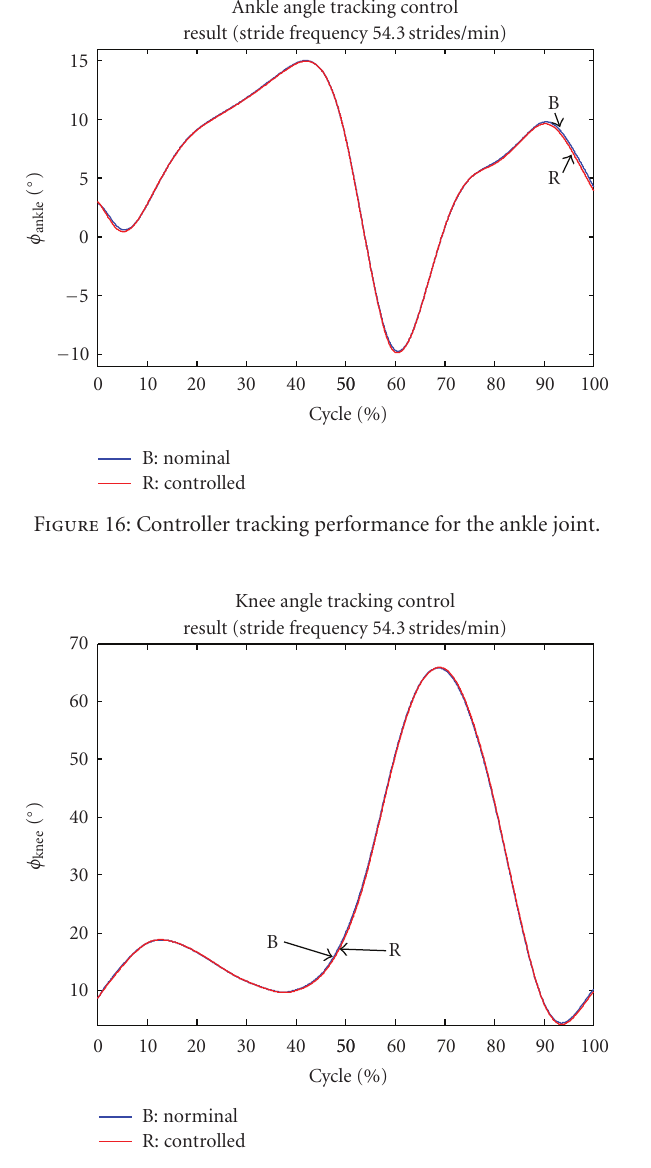
Figure 17: Controller tracking performance for the knee joint angle.